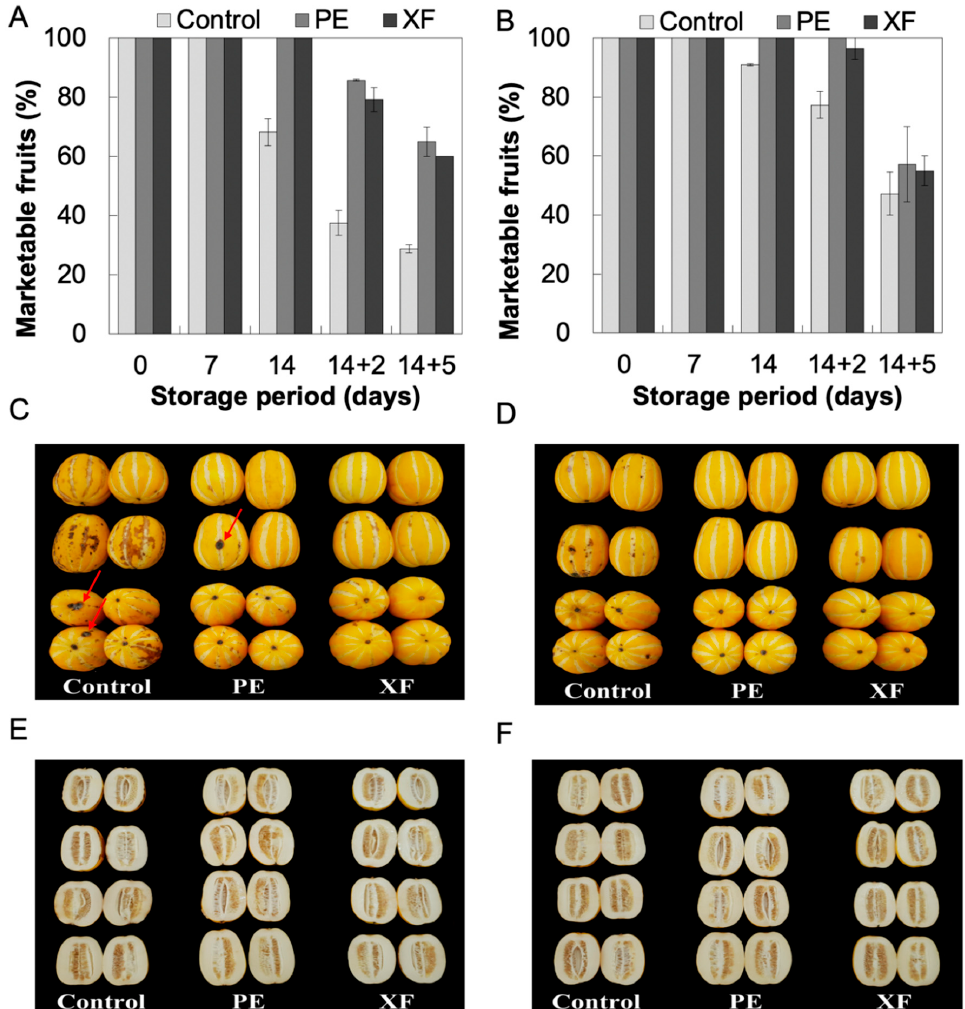
Figure 7. Effect of modified atmosphere packaging on overall appearance of oriental melons. Marketability of oriental melons that were stored at 4 °C ( A ) or 10 °C ( B ) for 14 days (14) and transferred to 20 °C for another two or five days (14 + 2 or 14 + 5). Representative images from oriental melon stored at 4 °C ( C , E ) or 10 °C ( D , F ) for 14 days, and transferred to 20 °C for another five days. Red arrows in C indicate mold damage by fungi.